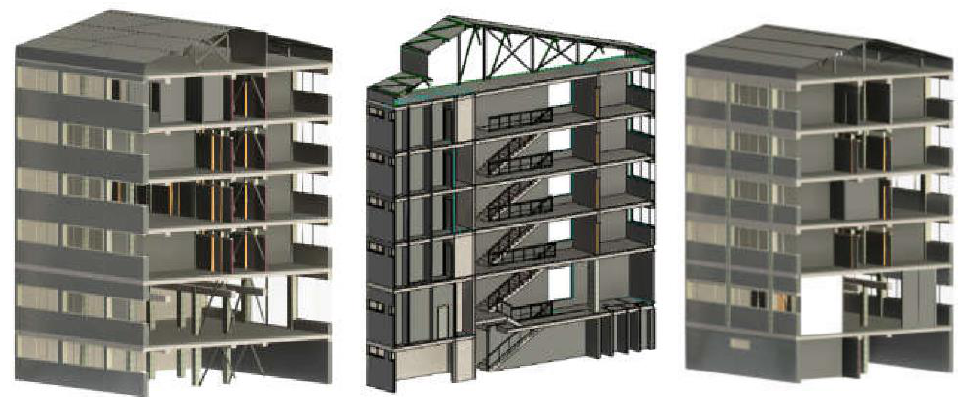
Figure 14. BIM model of the case study building.